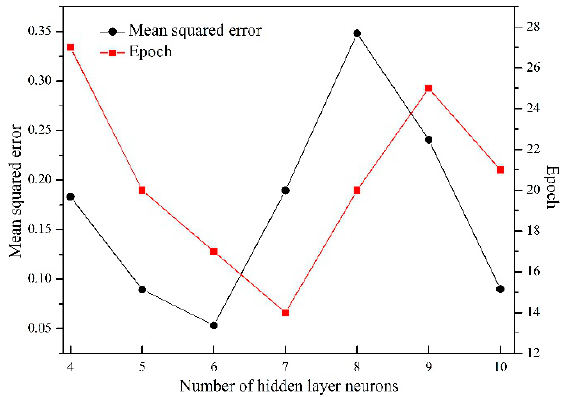
Figure 3. Correspondence between the network error and the number of hidden layer neurons.